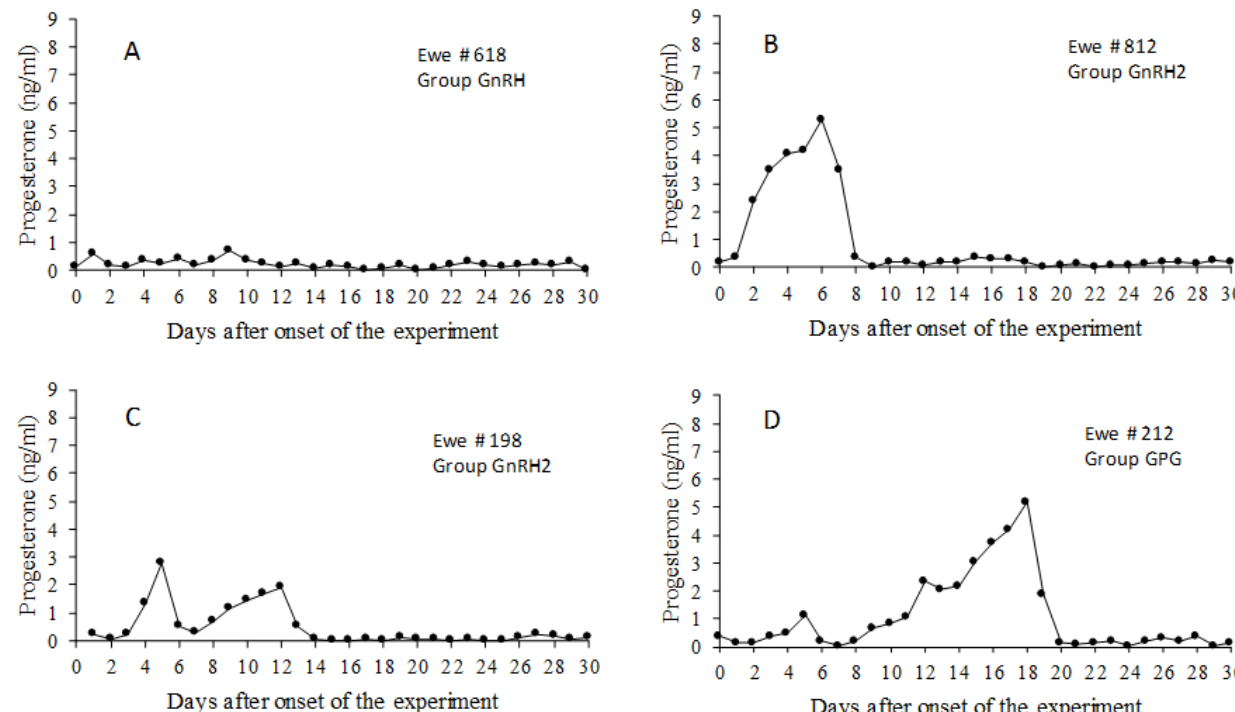
Figure 3. Representative progesterone profiles of the different types of response to treatment in experiment 1. (A) No ovarian response to treatment; (B) One short cycle followed by ovarian inactivity; (C) Two consecutive short cycles followed by ovarian inactivity; (D) One short cycle followed by a normal length cycle before returning to ovarian inactivity. The number of ewes with each type of response in each treatment is shown in Table 1. Treatments: GnRH: The ewes were treated with 4.2 μg of GnRH on day 0; GnRH2, Administration of 4,2 μg of GnRH on days 0 and 7; GPG, The ewes were treated with GnRH on day 0, PGF2 α on day 6 and GnRH on day